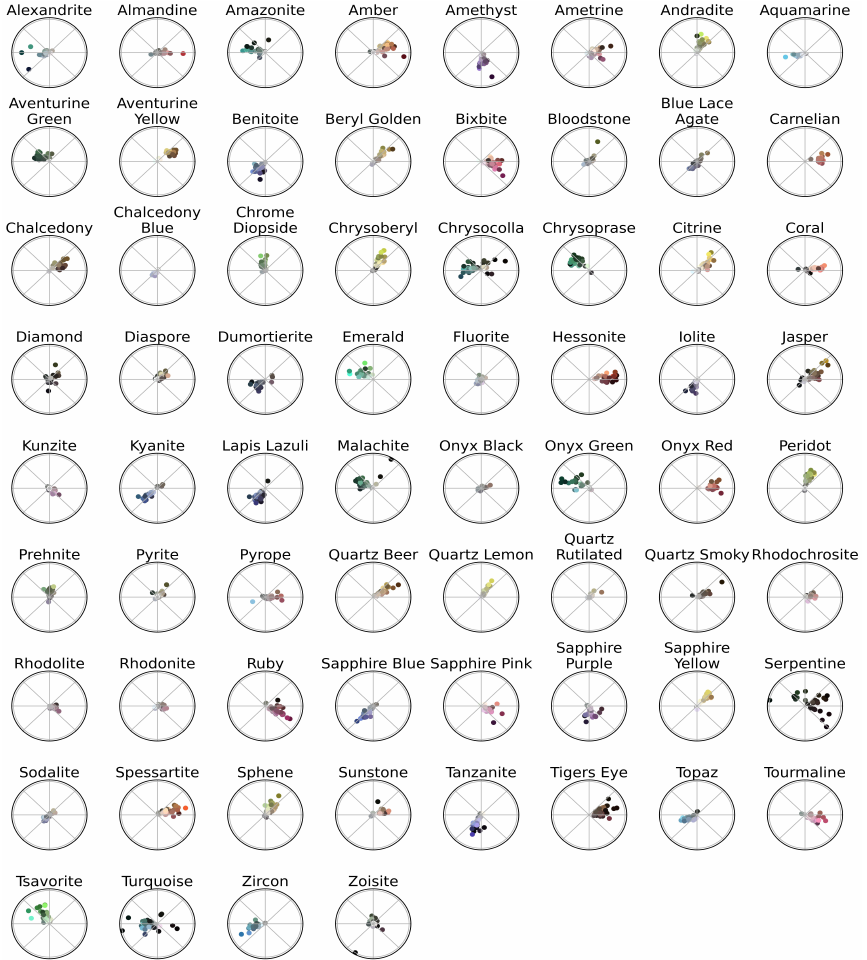
Figure 5. Illustration of the central colour characteristics for all the images of the training data represented in the three colour spaces. ( a ) Red–Green–Blue (RGB). ( b ) Hue–Saturation–Value (HSV). ( c ) CIELAB. It should be noted that, visually, HSV provides better discrimination as the colours are ranked, in this case along the horizontal axis. HSV can also be displayed in polar plots as Hue is a circular property.